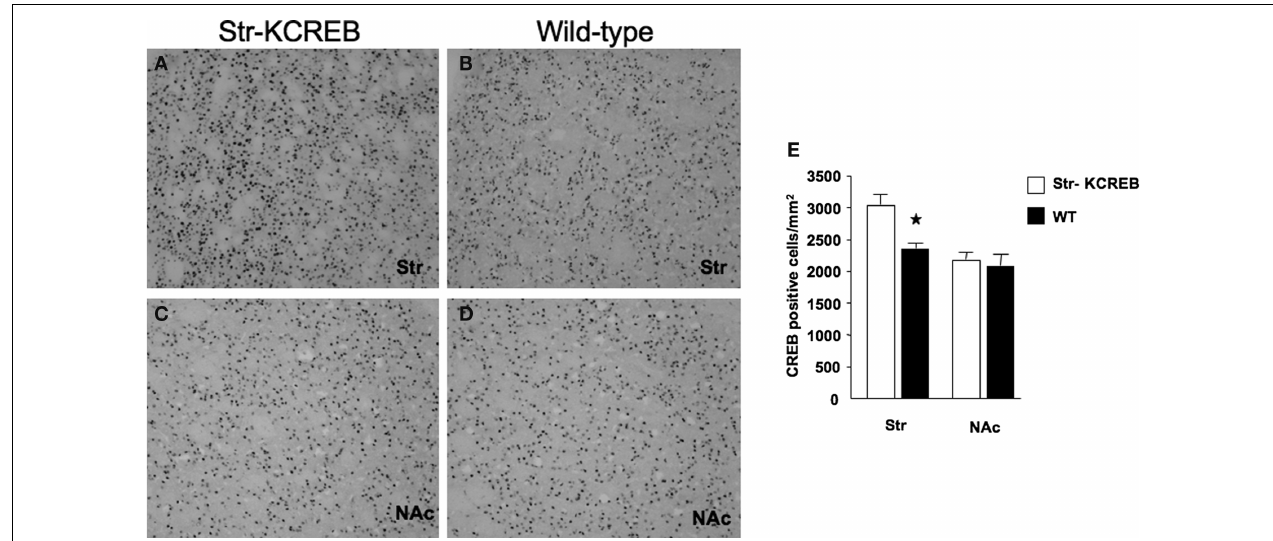
FIGURE 1 | Immunohistochemical characterization of KCREB expression in str-KCREB mice. Sections from str-KCREB and control mice stained with an anti-CREB antibody, which recognizes both endogenous CREB and KCREB, showed increased CREB immunoreactivity in the nuclei of dorsal striatum (str) neurons of str-KCREB mice (A) relative to wild-type (WT) controls (B) . In the accumbens region (NAc), of str-KCREB animals (C) the levels of the transgene were much lower than in dorsal portion, and CREB immunoreactivity was